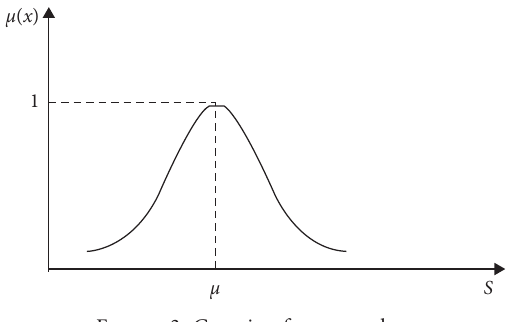
Figure 3: Gaussian fuzzy